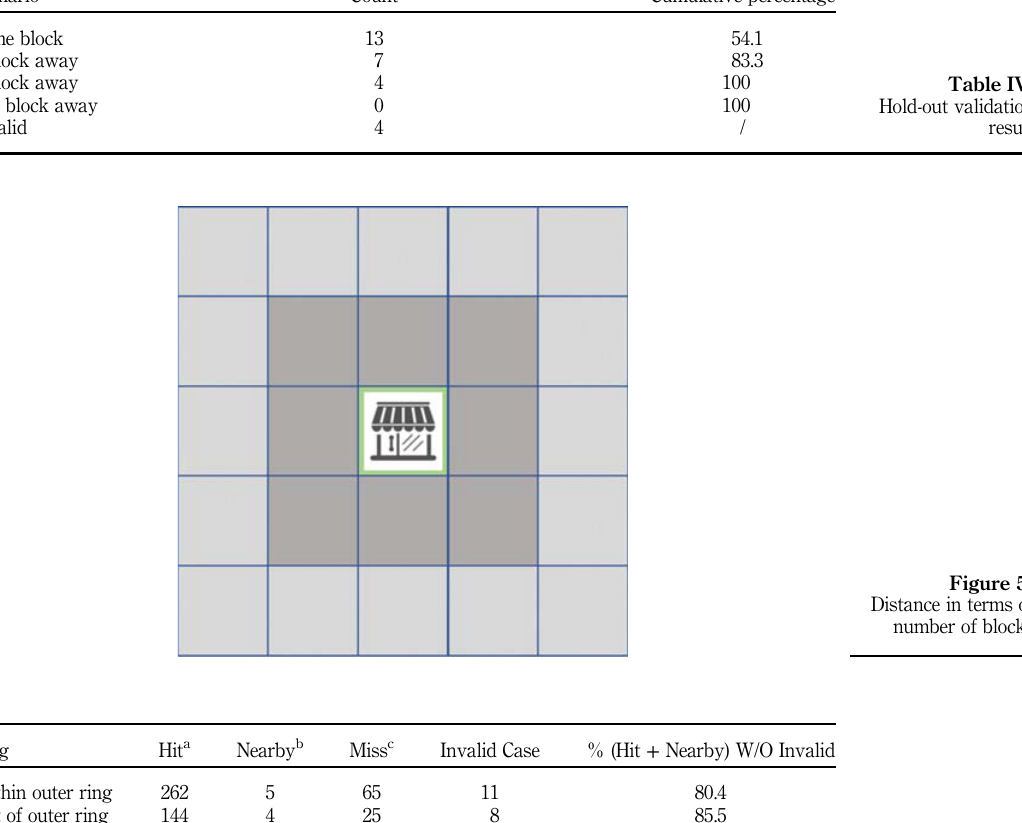
Table V. Validation result